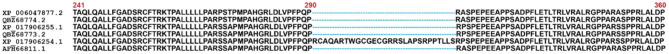
Alignment of buffalo and goat AMH proteins (QBZ68774 and QBZ68773) with reference AMH proteins (XP_006047877, XP_017906255, XP_017906254 and AFH66811). Goat AMH isoform 1 (XP_017906254.1) with additional 28 amino acids are shown.